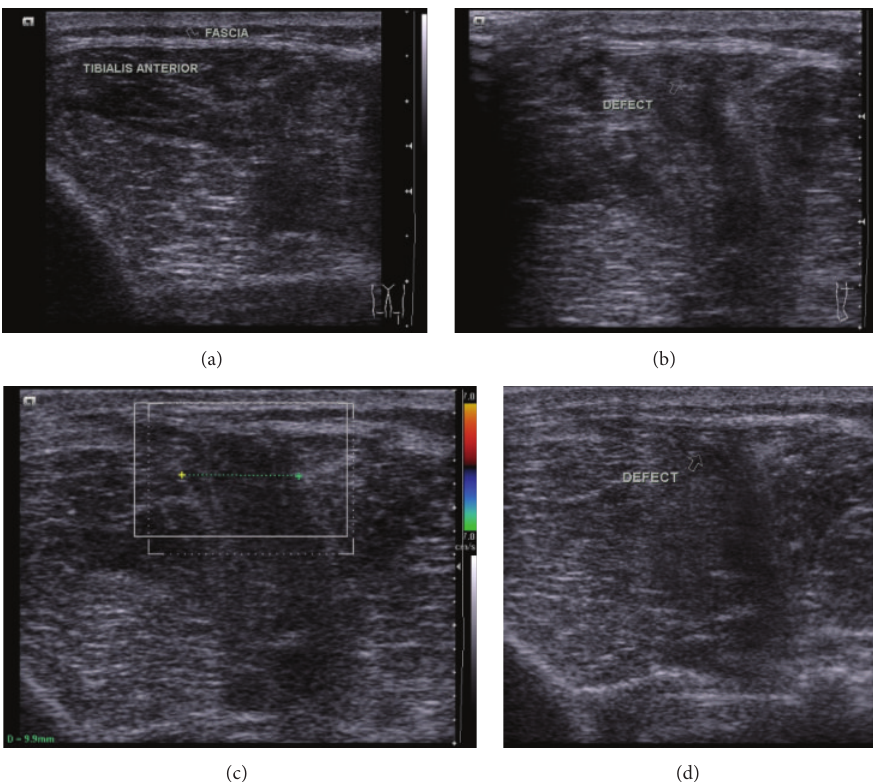
Figure 1: (a) Longitudinal section on the anterolateral aspect of left upper leg superior to the site of muscle hernia showing intact echogenic fascia with underlying tibialis anterior muscle. (b) Transverse section on the anterolateral aspect of left upper leg in standing position showing a defect in echogenic fascia (marked by arrow) with an increase in herniation of underlying tibialis anterior muscle through the defect. (c) Transverse section on the anterolateral aspect of left upper leg in standing position showing the defect of size 9.9 mm in echogenic fascia with herniation of underlying tibialis anterior muscle through the defect. (d) Longitudinal section on the anterolateral aspect of left upper leg at rest at the site of muscle hernia showing a defect in echogenic fascia with herniation of underlying tibialis anterior muscle through the defect (marked by arrow).